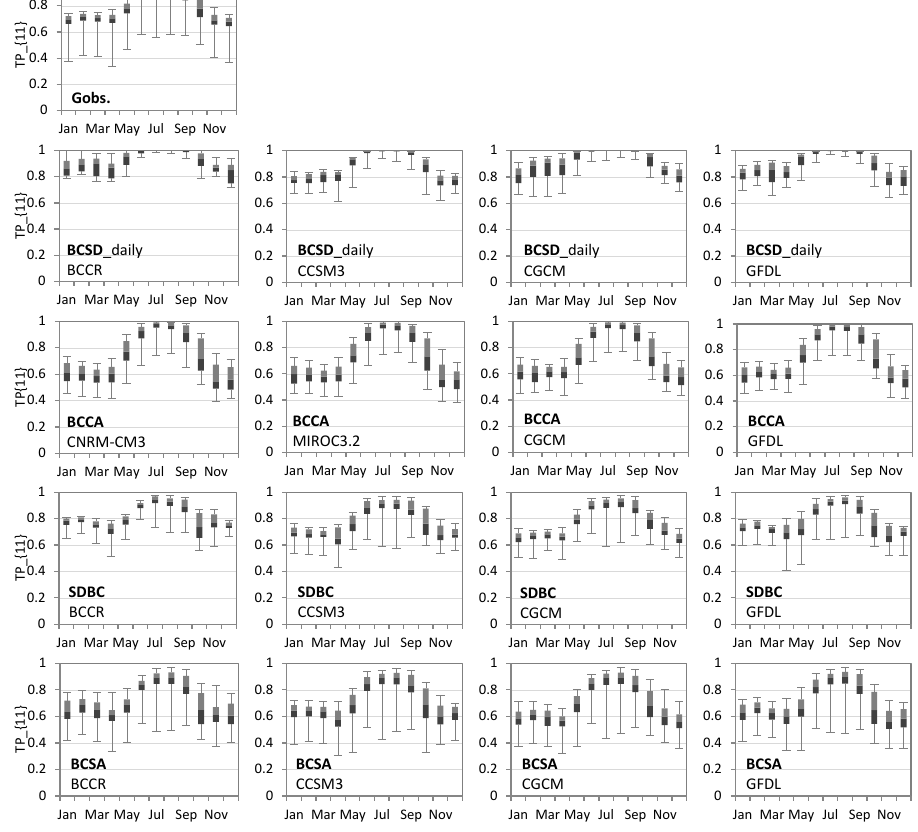
Fig. 13. Comparisons of monthly first-order wet to wet transition probability (TP_{11}) for observations (first row), BCSD_daily results (second row), BCCA results (third row), SDBC (fourth row), and BCSA results (fifth row) for 4 GCM products over all grids in the study area. Box plot presents minimum, 10th percentile, median, 90th percentile, and maximum over the grids.